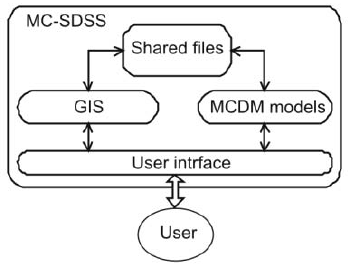
Fig. 2. Tight MC - SDSS coupling